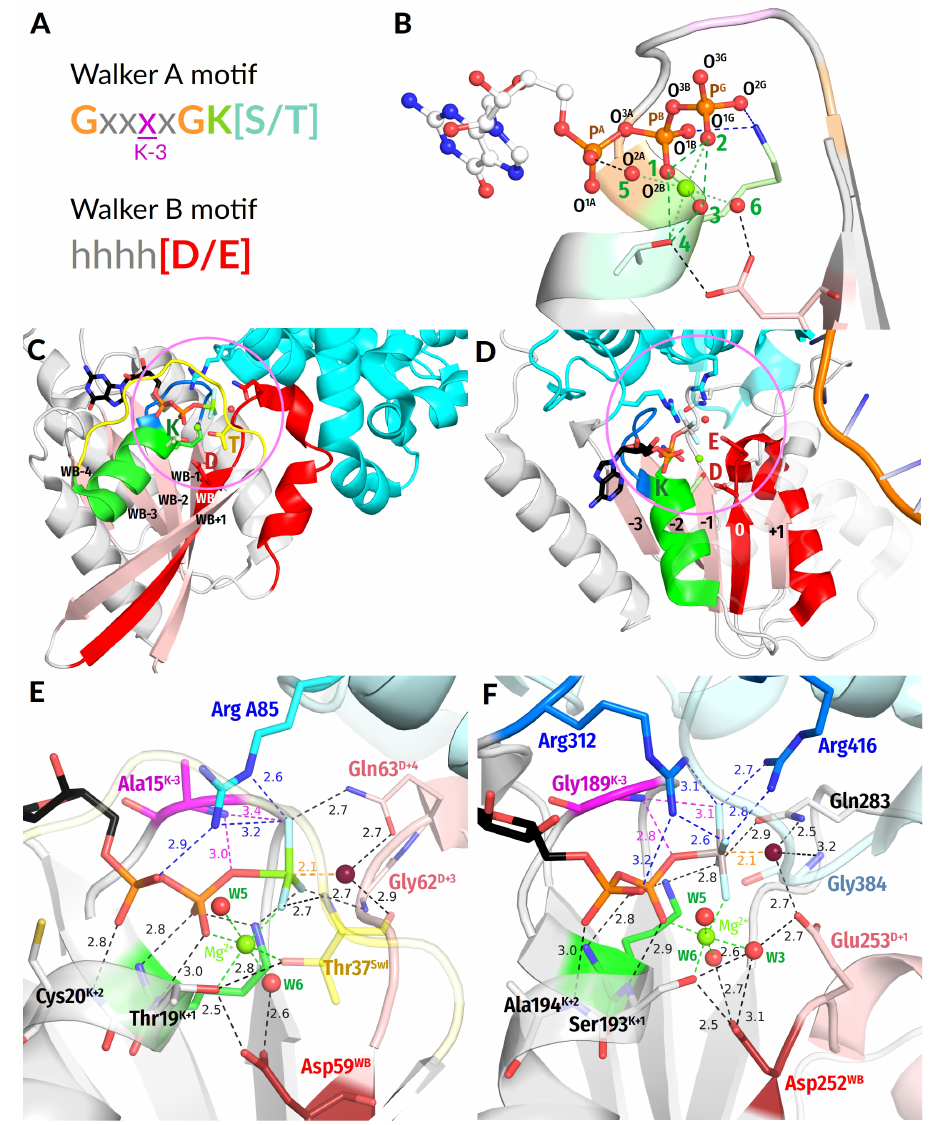
Figure 1. P-loop-fold NTPases . ( A ) Conserved Walker motifs in P-loop NTPases. ( B ) Naming of atoms according to IUPAC recommendations for nucleoside triphosphates [48] and typical coordi- nation of Mg 2+ by ligands, which are numbered in green. ( C , D ) Typical folds of P-loop NTPases. ( C ), GTPase Rho with its activator RhoGAP, (PDB ID 1OW3 [44]). ( D ) Chikungunya virus nsP2 SF1-helicase (PDB ID 6JIM [56]). Colour code: Polypeptide chains of P-loop domains are shown as grey cartoons; polypeptide chains of the activating partner are shown as cyan cartoons; the β -strands are coloured pink; α 1 -helix, green; P-loop, blue; Walker B motif and the following residues, red; Switch I loop, yellow. ( E , F ) Close-ups of structures shown in ( C , D ) as examples of typical catalytic sites of P-loop NTPases. ( E ) GTPase Rho with its activator RhoGAP and the transition state ana- logue GDP-MgF 3 − , (PDB ID 1OW3 [44]). ( F ) Chikungunya virus nsP2 SF1 helicase complexed with transition state analogue ADP-AlF 4- (PDB ID 6JIM [56]). Colour code: Nucleotides, their